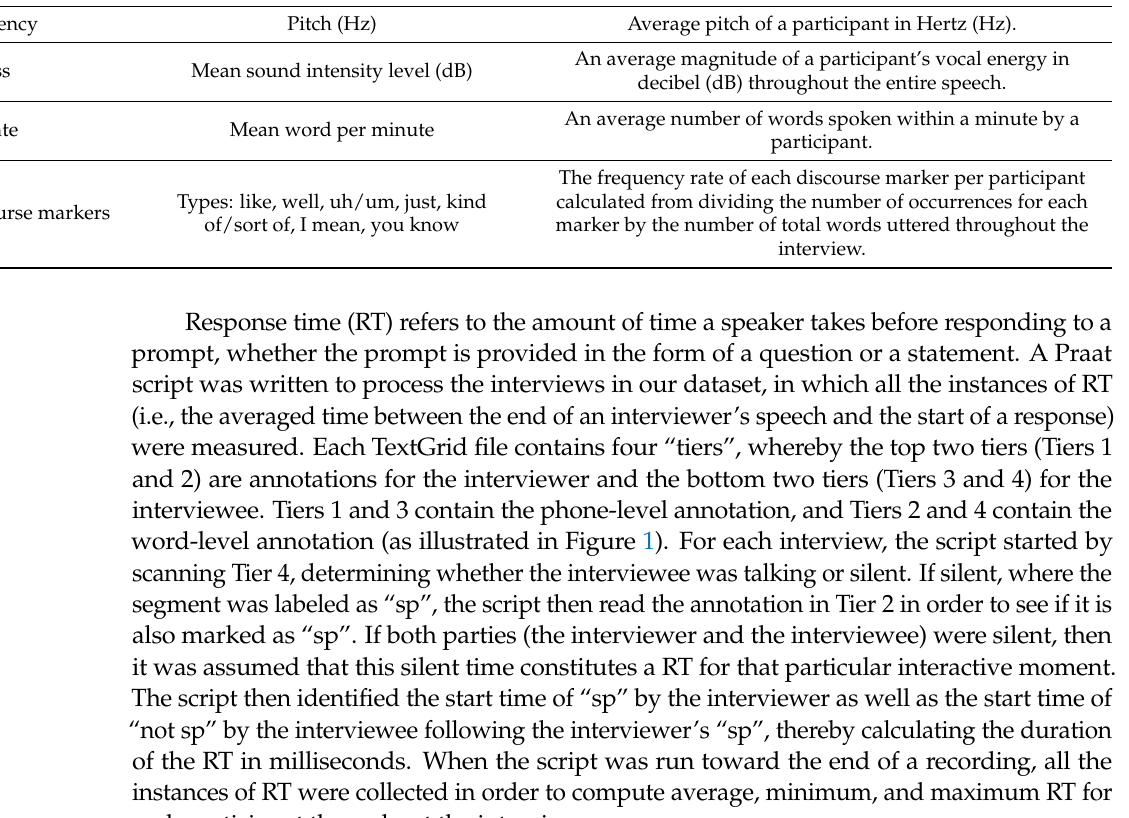
Table 1. Descriptions of the extracted features to identify the relationships with the personality traits. Independent Variables Description Gender Male or Female The Gender of a Participant Response time Mean response time